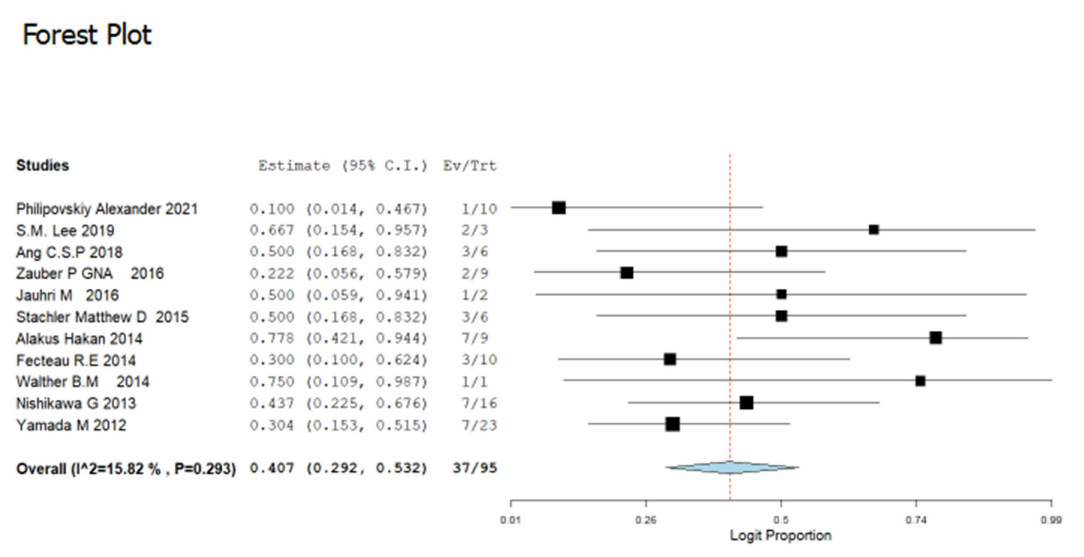
Figure 3. Forest plot for GNAS codon R201C in CRC patients